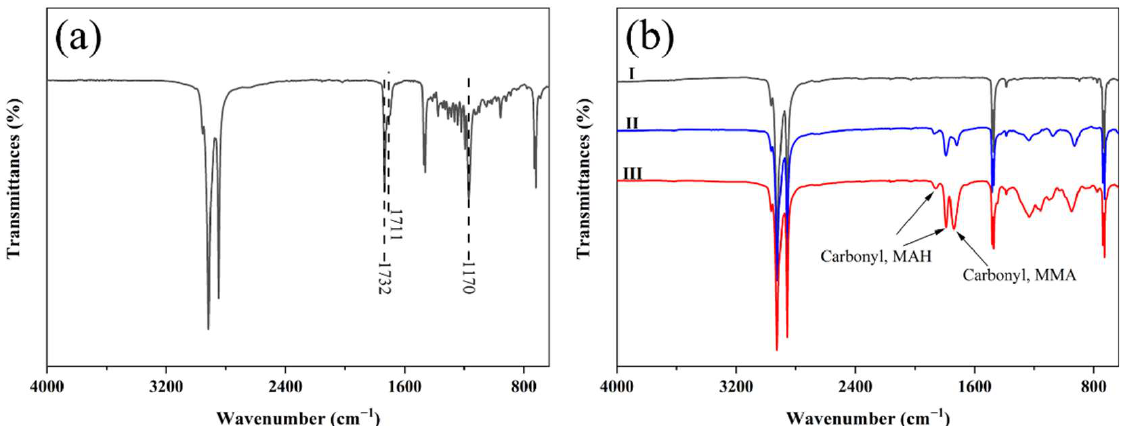
Figure 2. FTIR spectra of ( a ) BW, ( b ) PEW (I), PEW- g -MAH (II), and PEW- g -MAH-MMA (III).